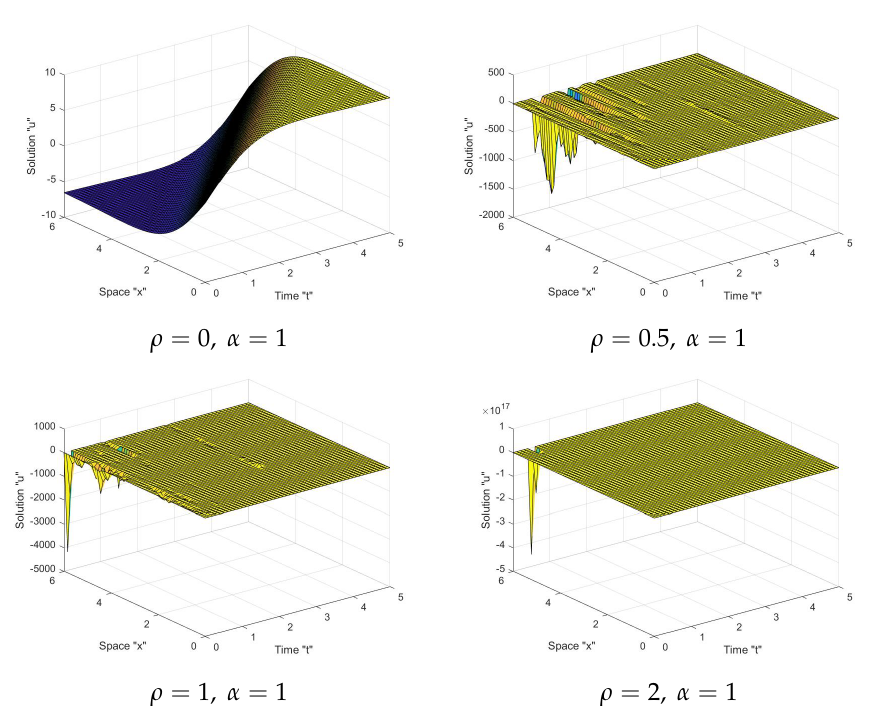
Figure 1. Graph of solution u 2 in Equation (21) with α = 1.